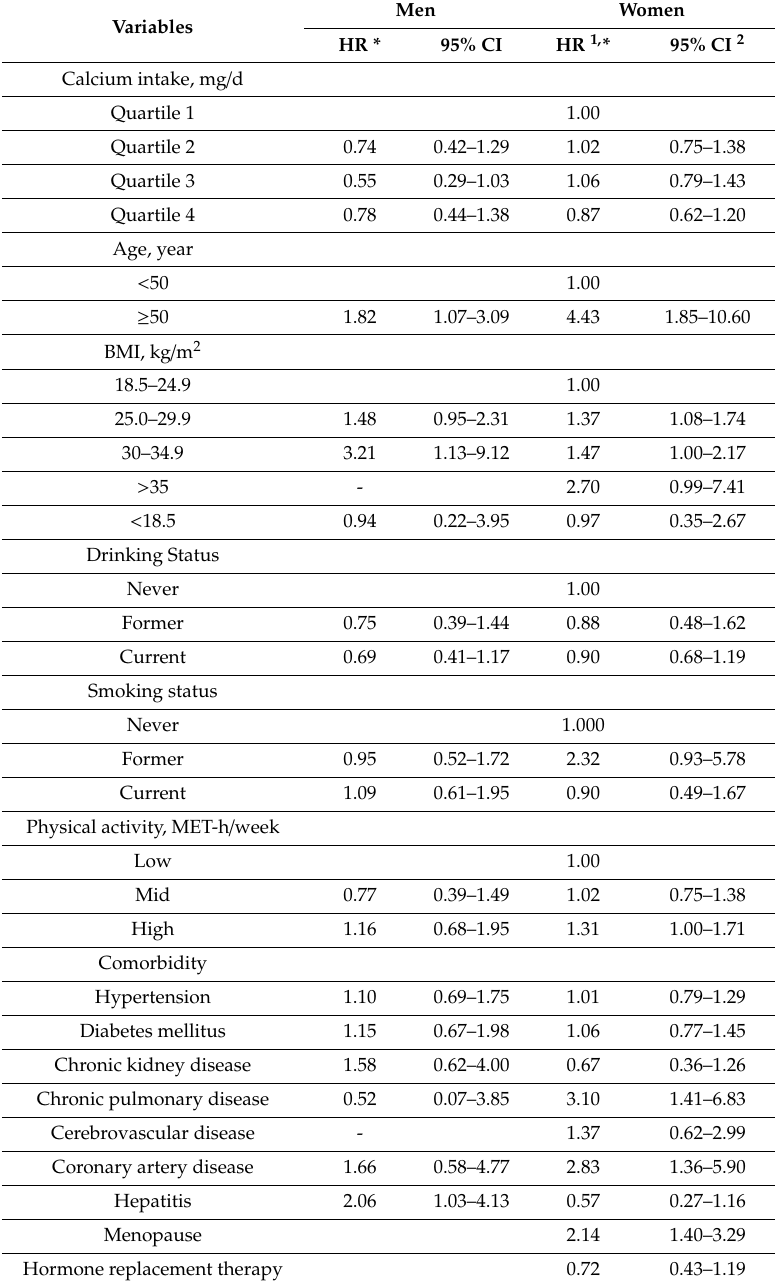
Table 3. Risk factors of osteoporosis in men and